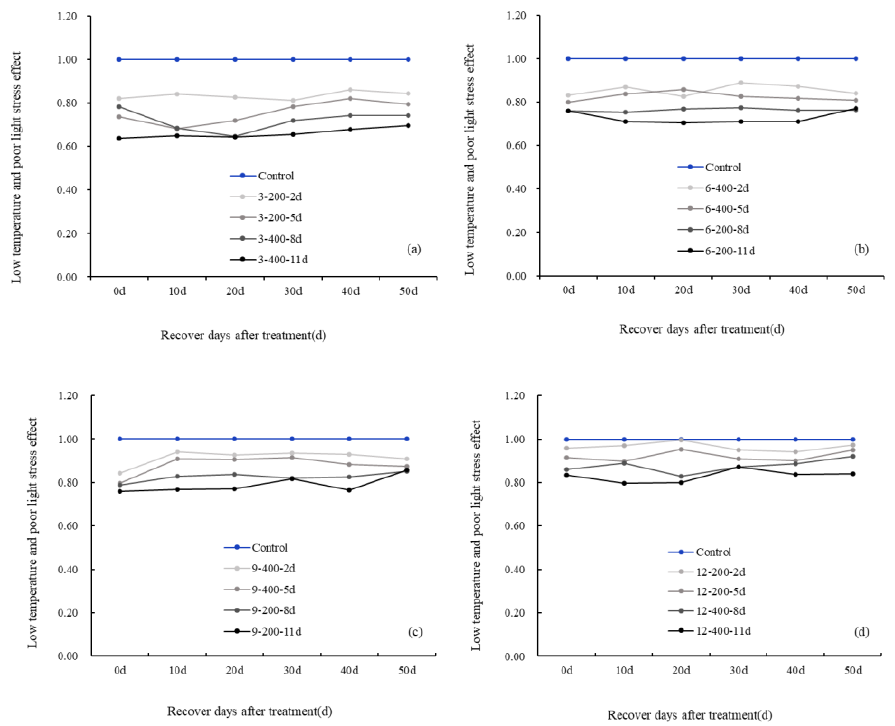
Figure 2. Stress effect under different LT and PL stresses. ( a ) Changes in stress effect with recovery days for each treatment at 3 °C; ( b ) changes in stress effect with recovery days for each treatment at 6 °C; ( c ) changes in stress effect with recovery days for each treatment at 9 °C; ( d ) changes in stress effect with recovery days for each treatment at 12 °C. Note: The stress effect represents the level of stress, the lower the stress effect, the more severe the stress on cucumber. Control represents the stress effect on cucumbers under normal growth conditions (here 1).